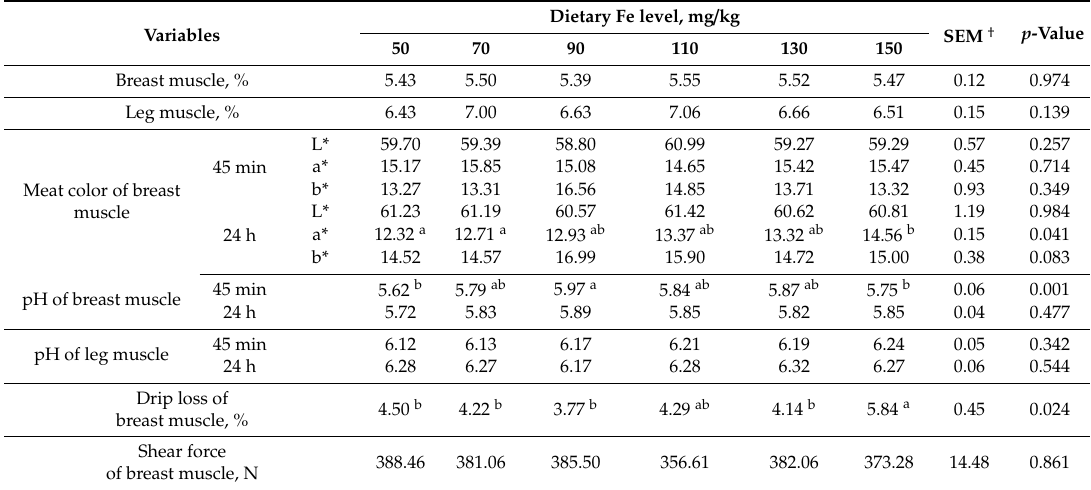
Table 5. E ff ects of dietary Fe between 43 and 63 d on meat quality of Chinese yellow broilers.